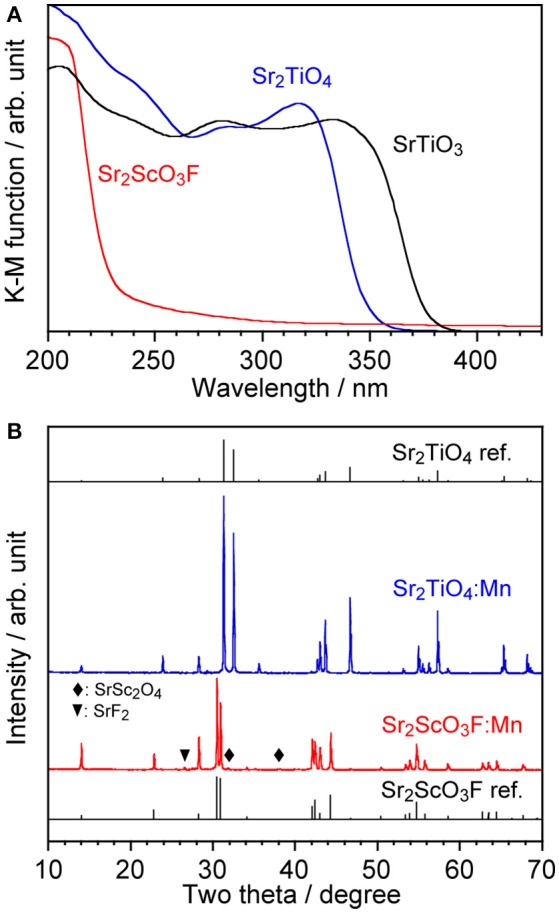
(A) Diffuse reflectance spectra of non-doped Sr2TiO4, Sr2ScO3F, and SrTiO3 and (B) XRD patterns of Sr2TiO4:Mn and Sr2ScO3F:Mn with reference patterns.